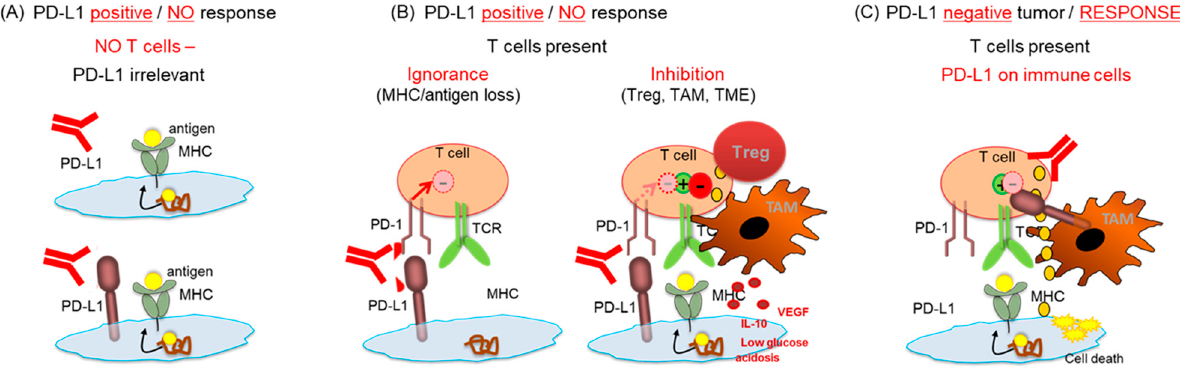
Figure 2. PD-L1 cannot be a sufficient predictor of response to ICI: ( A ) If T cells are not present, response to anti-PD-1//L1 therapeutics cannot occur, irrespective of PD-L1 expression. ( B ) Despite the presence of T cells and PD-L1 positivity, response might not occur if the tumor lacks MHC/antigens (T cell ignorance), or if suppressive cells (Treg, TAM) or inhibitory soluble metabolites are present (T cell inhibition). ( C ) Response might occur despite absence of PD-L1 on tumor cells if PD-L1 is expressed on other cells, i.e., macrophages, a situation which is frequent in BC.